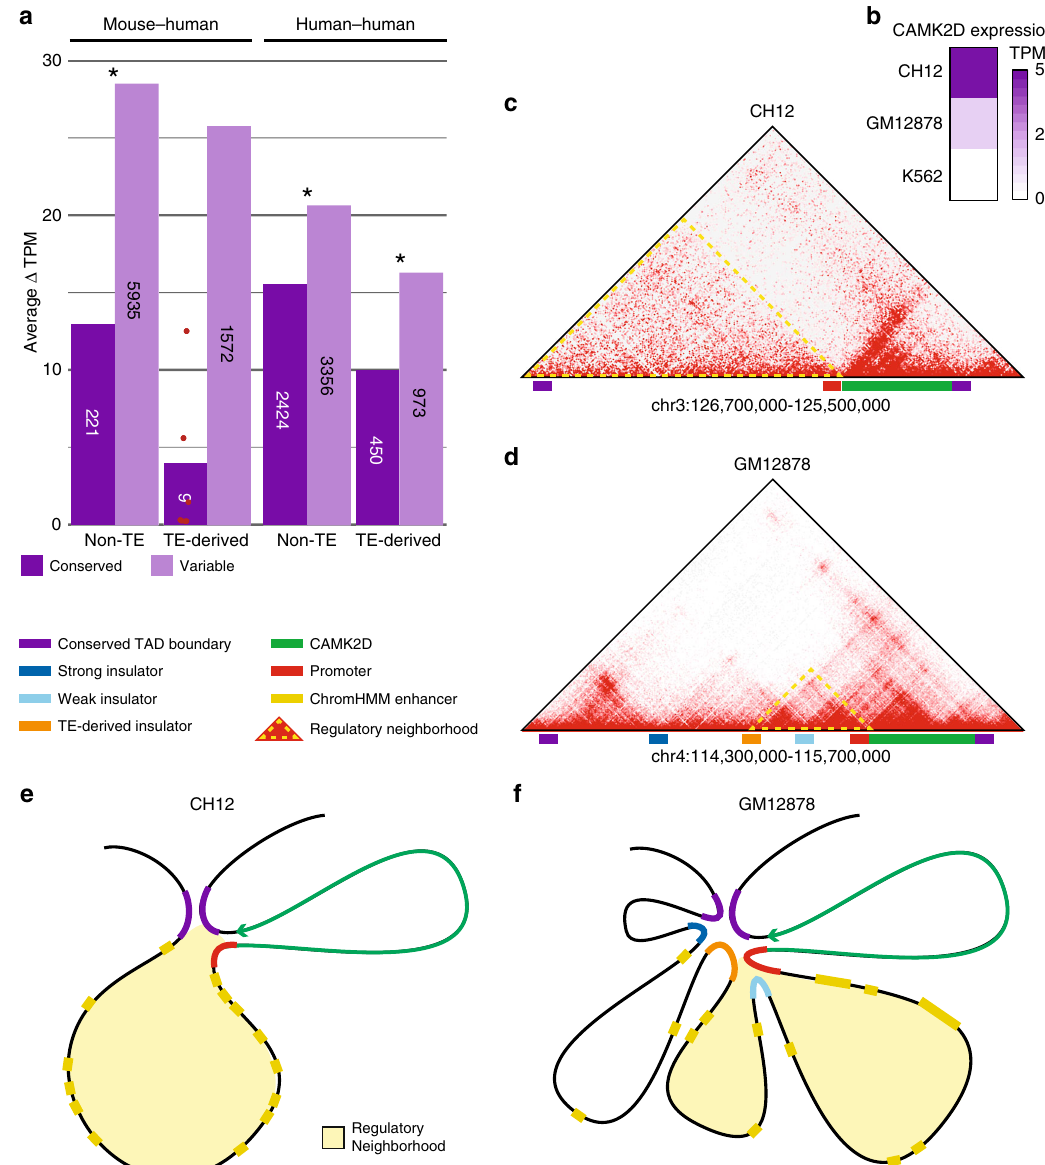
Fig. 7 TE-derived and native variable loops are associated with variable gene expression. a Bar plots show average differences in target gene expression, expressed as Δ TPM (see “ Methods ” for derivation), across species and cell types for conserved and variable enhancer – promoter loops. Loops are de fi ned as “ TE-derived ” , if one or both of the CTCF sites de fi ning the loop boundaries is embedded within a TE and “ native ” otherwise. Bars are annotated with the number of contributing observations, with red points indicating observed Δ TPM values for conserved, TE-derived loops in the mouse – human comparison, for which only nine observations were available. *One-sided Wilcoxon p -value < = 0.01. b – f A variable enhancer – promoter loop associated with variable CAMK2D gene expression. b CH12, GM12878, and K562 CAMK2D expression in transcripts per million (TPM). c Hi-C plot for the TAD enclosing CAMK2D in mouse CH12 cells. Relevant features are highlighted along the x -axis (see color key). The CAMK2D -regulatory neighborhood (outlined in yellow) extends from the promoter to the distal TAD boundary, and is enriched throughout for enhancer – promoter interactions. d Hi-C plot showing the CAMK2D TAD in human GM12878 cells. Three CTCF-tethered loop anchors appear to act as insulators, dividing the TAD into four distinct subloops. A TE-derived CTCF- binding site insulates the CAMK2D promoter from contact with the two furthest-distal loops, thus restricting the CAMK2D -regulatory neighborhood to two proximal subloops separated by an embedded, native insulator element. Both of these subloops are enriched for enhancer – promoter interactions. e , f Illustration of chromatin loops detected in mouse CH12 ( e ) and human GM12878 cells ( f ). Relevant features in both genomes are indicated by colored bars (see color key), and CAMK2D -regulatory neighborhoods are highlighted with light yellow fi ll. e In CH12 cells, multiple enhancers are free to interact with the CAMK2D promoter, evident as diffuse enrichment within the regulatory triangle in the CH12 Hi-C map ( c ). f In GM12878 cells, the CAMK2D - regulatory neighborhood is much more restricted. The 5 ′ boundary is demarcated by a TE-derived CTCF-binding site, which sequesters further-distal enhancers falling within two distal loops, included in the CH12 CAMK2D -regulatory neighborhood, from promoter interactions. The two proximal loops remaining in the regulatory neighborhood contain both multiple enhancer elements (Supplementary Fig. 13H) and an internal insulator element possibly re fi ning enhancer – promoter interactions between loci in both